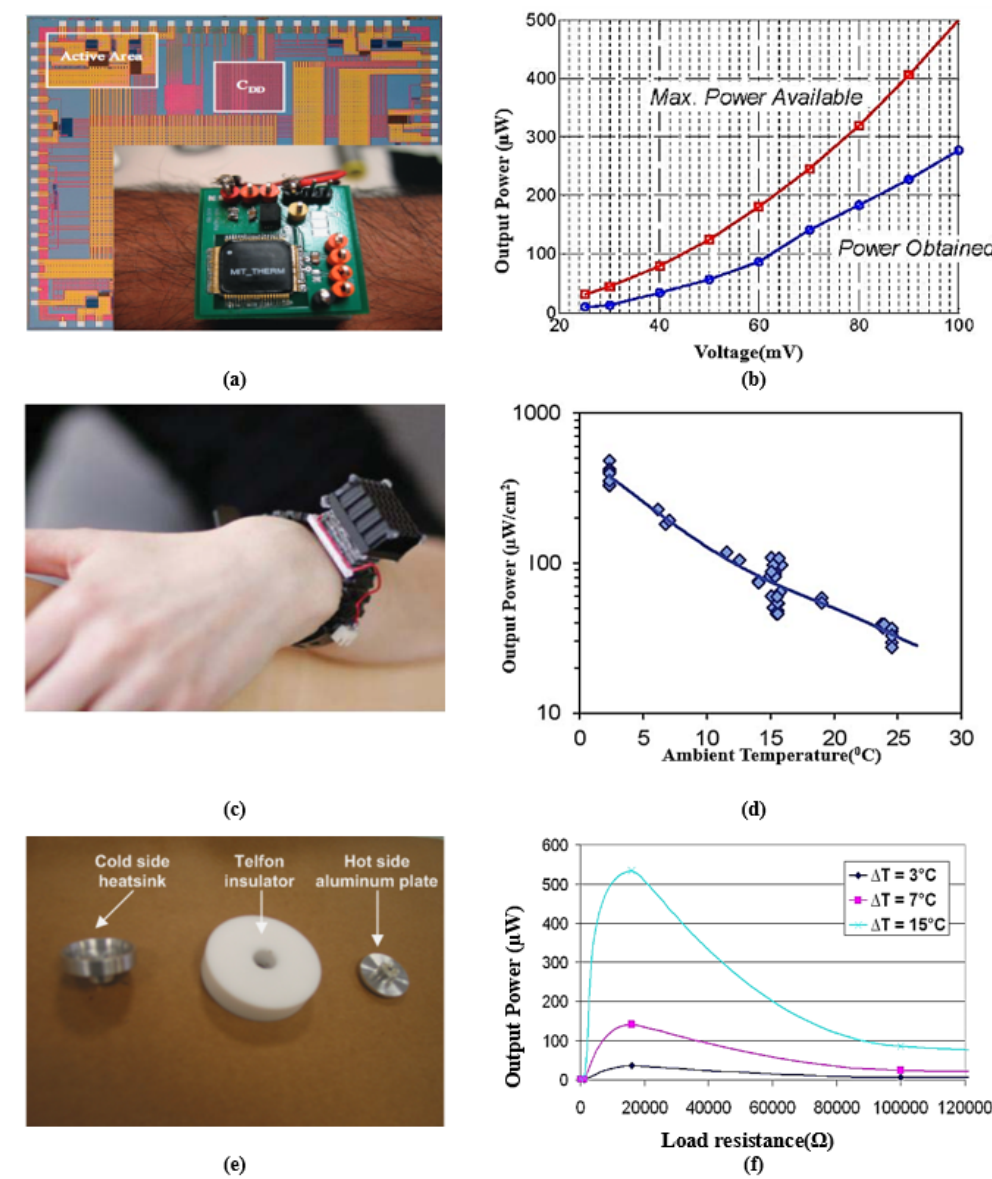
Figure 5. ( a ) Interface circuit of thermal energy harvester where the inset presents the thermoelectric generator (TEG) chip worn on the arm. ( b ) Measured electrical power from the buck converter vs. maximum power available from the TEG. Reprinted with permission from [149]. Copyright 2010 IEEE. ( c ) Wearable TEGs with a 3 × 3 × 1.5 cm radiator. ( d ) Output power variation with ambient temperature for a TEG. Reprinted with permission from [154]. Copyright 2013 IEEE. ( e ) A prototype of a TEG, harvesting energy from the human body. ( f ) Output power obtained from a TEG at different loading conditions. Reprinted with permission from [155]. Copyright 2009